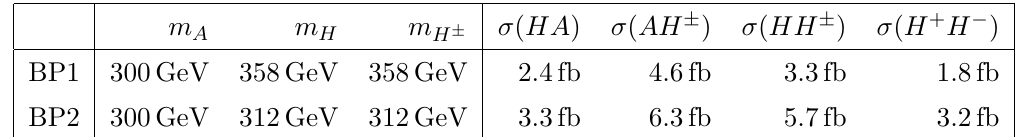
Table 1 . The mass parameters of the two benchmark points and the production cross sections at LHC 14 TeV. For (cid:27) ( AH (cid:6) ) and (cid:27) ( HH (cid:6) ), each H + contribution is roughly the twice the corre- sponding H (cid:0) contribution due to the PDF e(cid:11)ects, and both contributions are